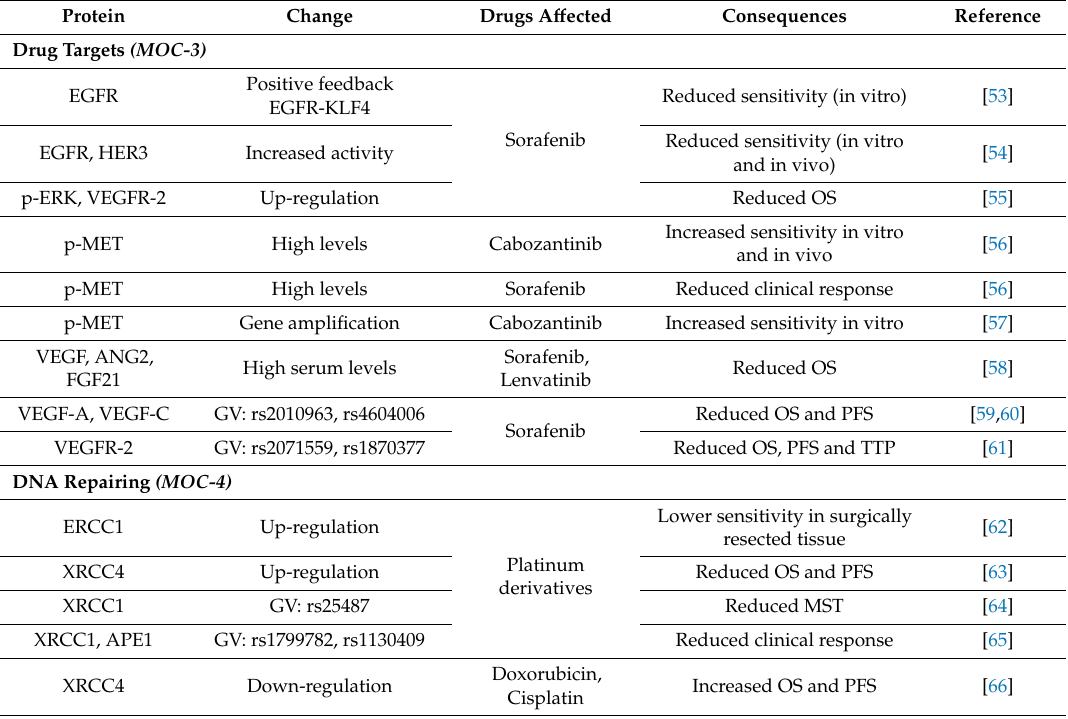
Table 2. Mechanisms of chemoresistance type 3 (MOC-3) and 4 (MOC-4) to drugs clinically used in